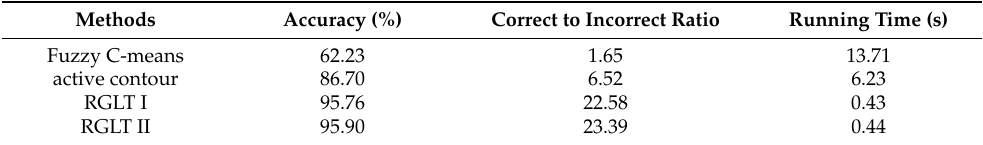
Table 3. Comparison of the overall accuracy and speed using several segmentation methods.